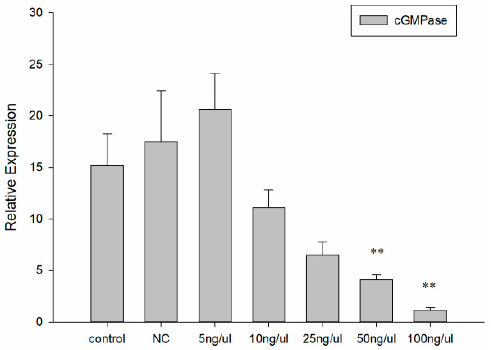
Figure 5. Screening of effective dsRNA action concentration of cGMPase . Control group was blank group, NC group was negative control group. Double asterisks mean a highly significant difference (** p < 0.01).